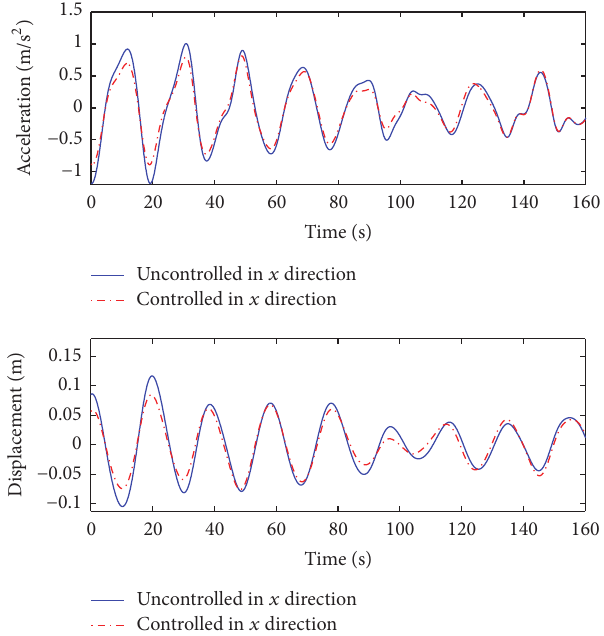
Figure 8: Dynamic responses of the tower top under wind load.